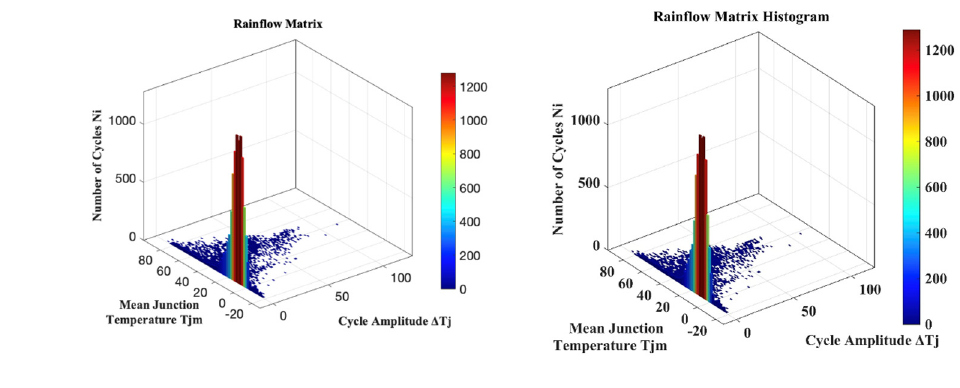
Figure 12. RF matrix in Denmark.